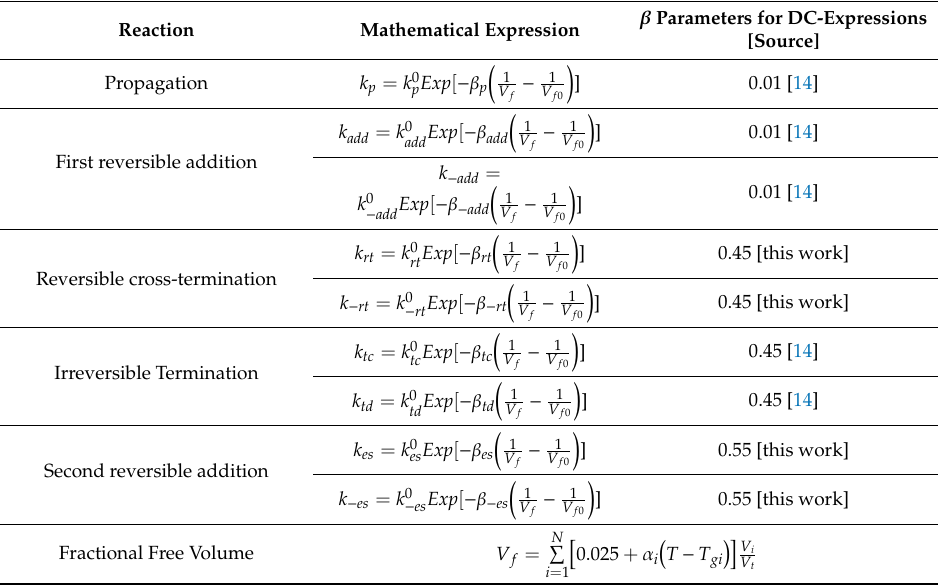
Table 2. Mathematical expressions for di ff usion-controlled (DC)-e ff ects.